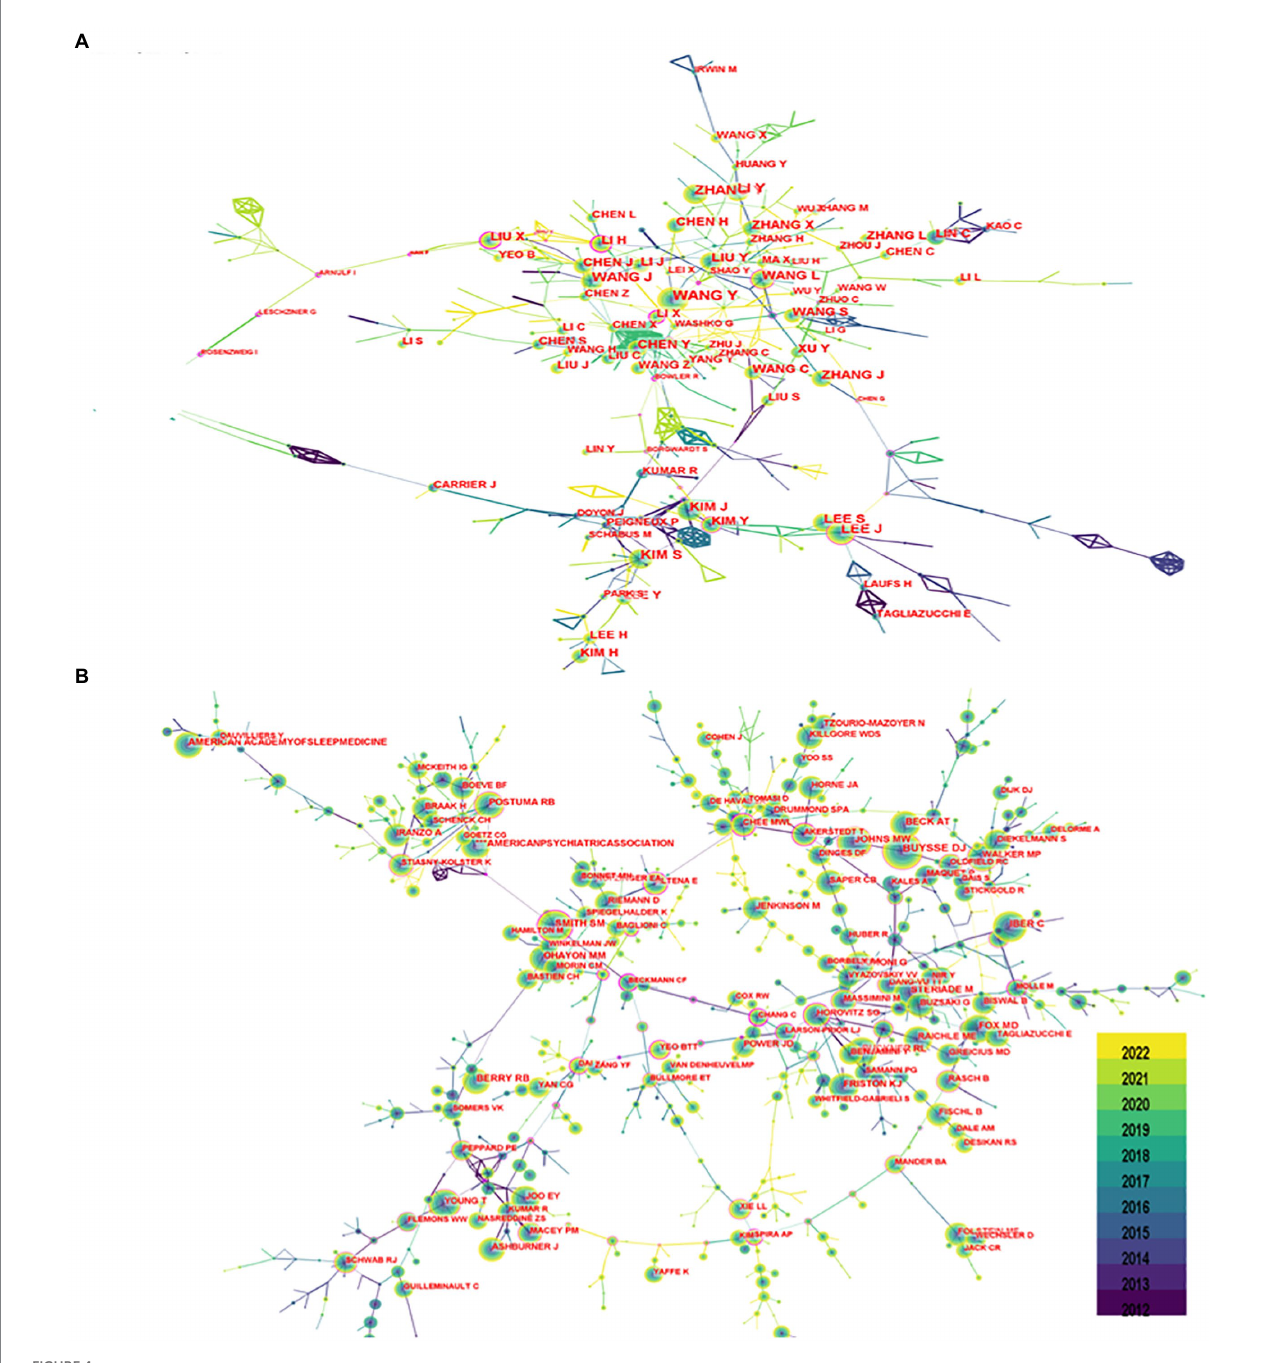
FIGURE 4 Author chart. (A) Shows the author graph, and (B) shows the co-cited author graph. The node size indicates the number of studies published or co-cited by the author, and a larger node suggests that the author has published more papers or co-cited more times. The closer the collaboration between two authors, the shorter the distance between the two